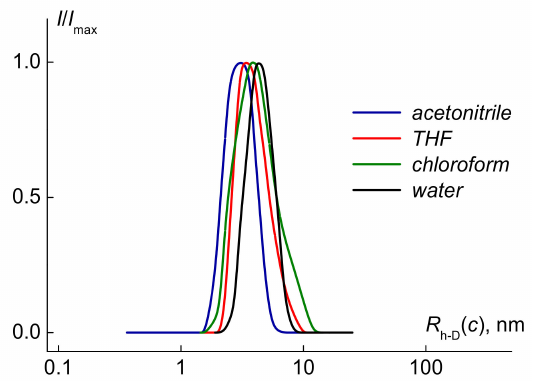
Figure 2. The hydrodynamic radii distribution for the solution of polyE7P10 at concentration c ≈ 0.005 g · cm − 3 . I max is the maximum intensity of scattered light for the given solution concentration. In all solutions, the asymmetry of the light scattering intensity was not observed for all copolymers. Therefore, the gyration radii of scattering objects could not be determined, and polymer molar masses M w were obtained by the Debye method (angle 90 ◦ ), using the formula